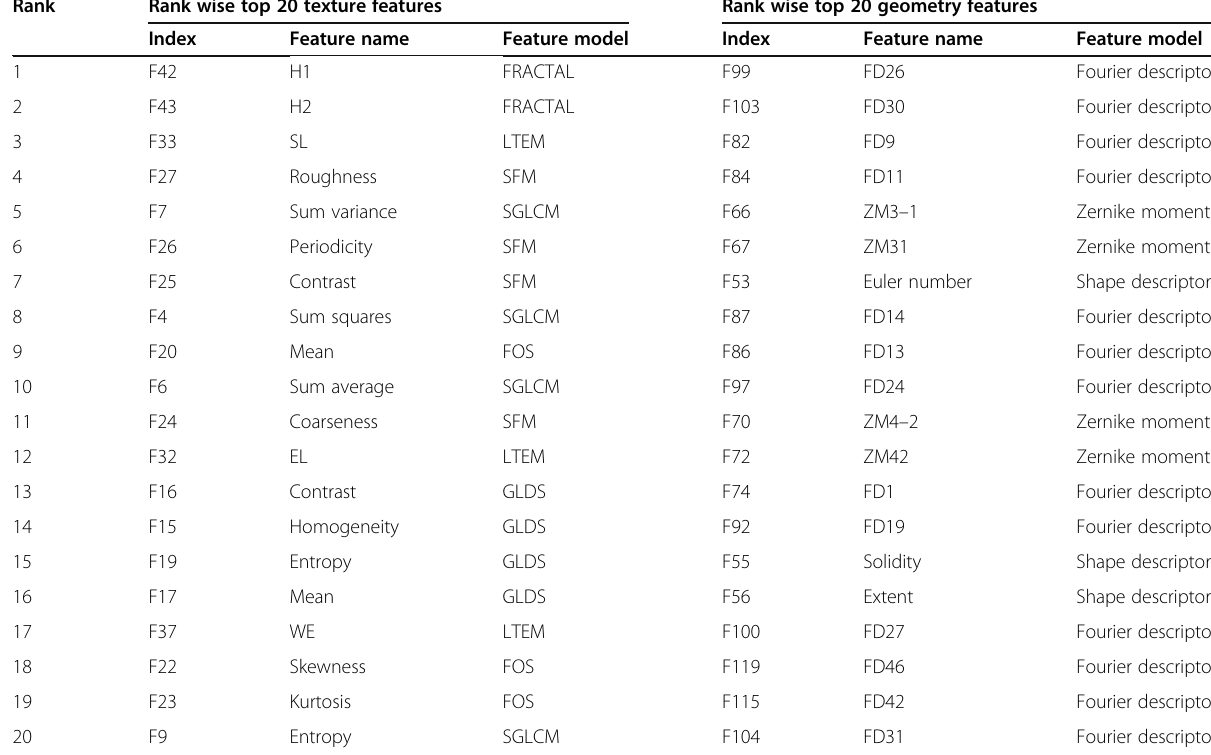
Table 10 Rank-wise lists of the top 20 most discriminative textures and the top 20 most discriminative geometric features selected by the Relief-F feature selection algorithm